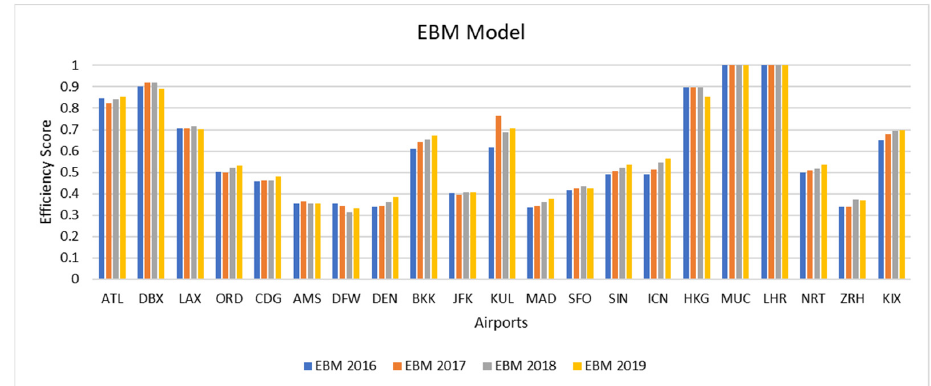
Figure 6. Efficiency score of the EBM model.